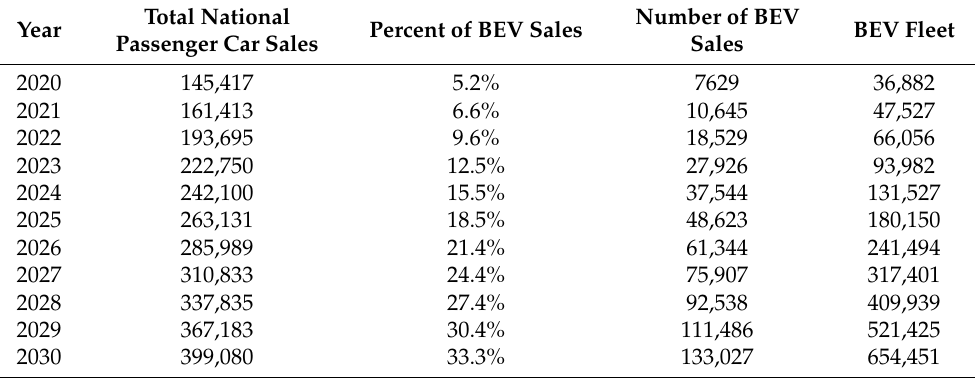
Table 5. Calculation of the BEV fleet for scenario 1.